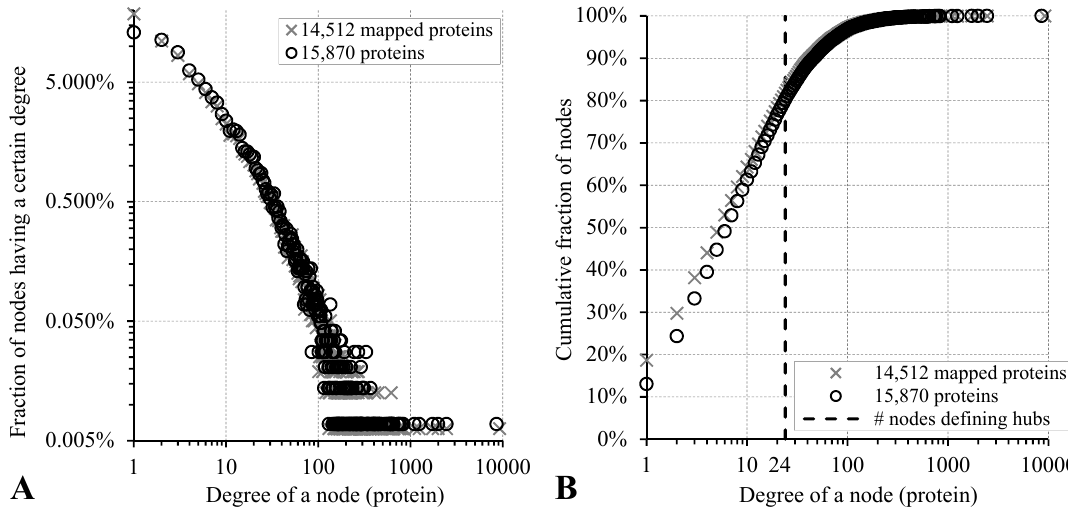
Figure 6. Connectivity of proteins in the human PPI network. Panel ( A ) summarizes the fraction of proteins (nodes in the PPI network) with a given number of PPI interactions (degree). Panel ( B ) gives the cumulative fraction of proteins having a degree less than the corresponding value on the x -axis. The circles (crosses) show the results for the original PPI network collected from mentha (the network where proteins were mapped to UniProt). The dashed vertical line in panel ( B ) shows the degree that demarcates hubs, which is defined as the 20% of the most connected nodes.